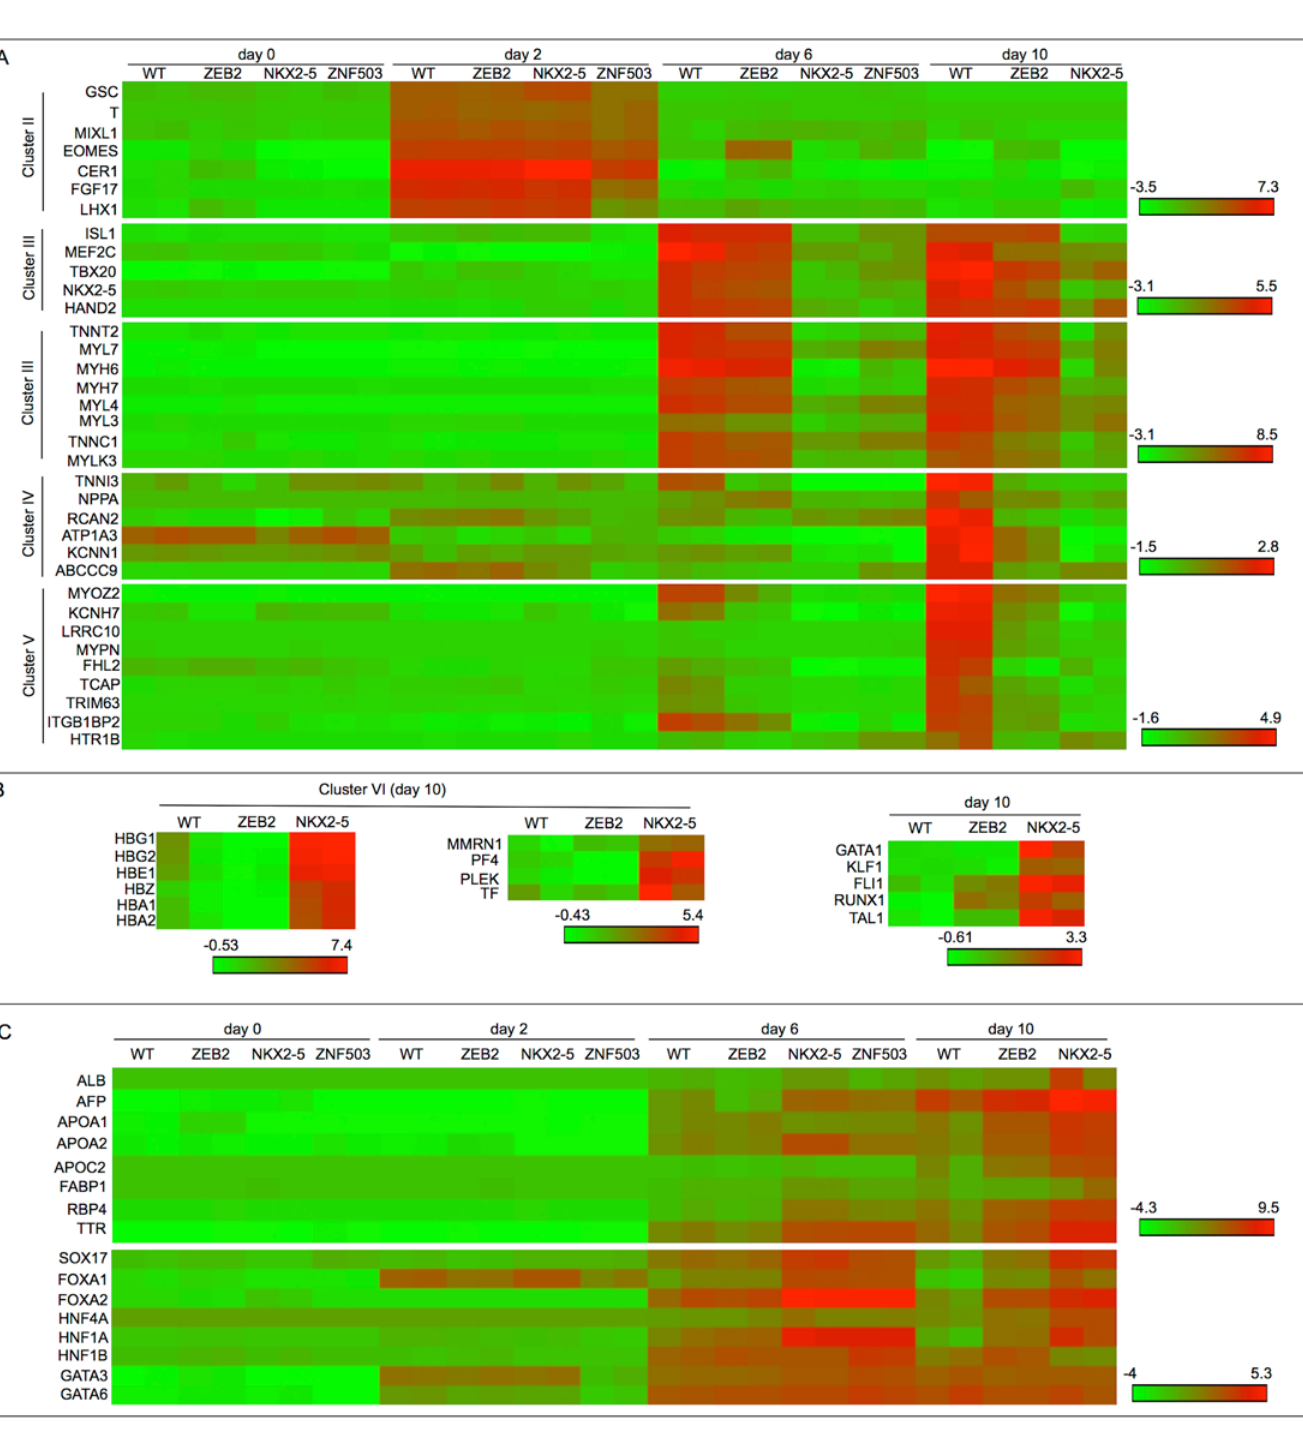
Fig 4. Transcriptome analysis reveals a role for cardiogenic TFs in activation of cardiac genes and repression of alternative cell fates. Matrix representations of gene expression patterns at different time points of differentiation along the cardiac lineage are shown for WT or shRNA-treated ESCs. (A) Gene expression patterns of mesendodermal (cluster II) and cardiac lineage genes (clusters III, IV, and V) at the indicated time points. (B) Gene expression patterns of the indicated haematopoietic genes at day 10. (C) Gene expression patterns of liver and definitive endodermal genes at the indicated time points.